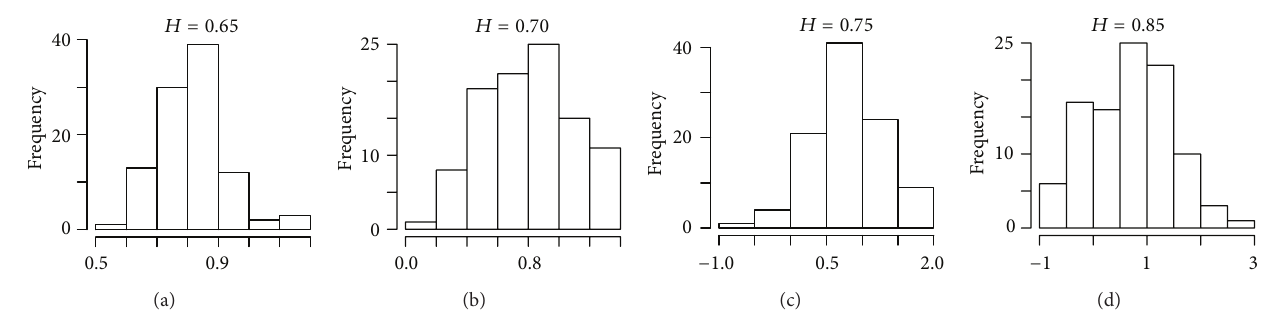
̂𝛽 ( 𝛽 = 0.8215 ) for different values of 𝐻 .